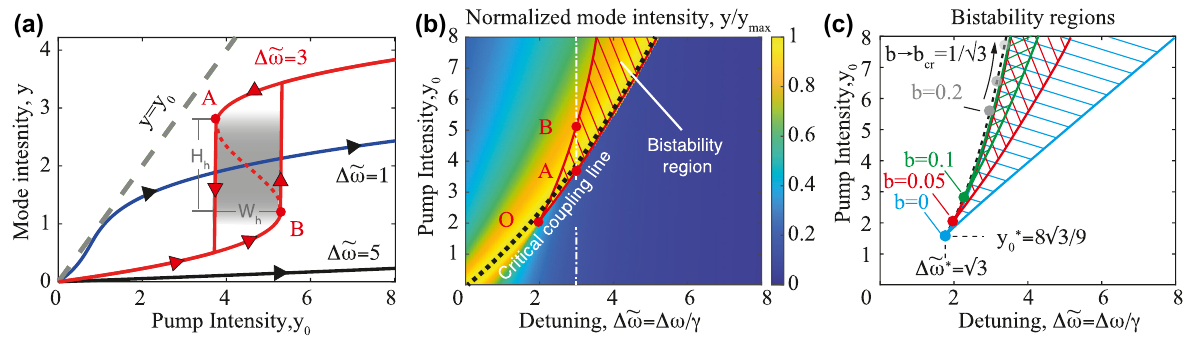
= 𝛼𝛾 | f | 2 ∕ 𝛾 3 for different detuning 0 r and width h